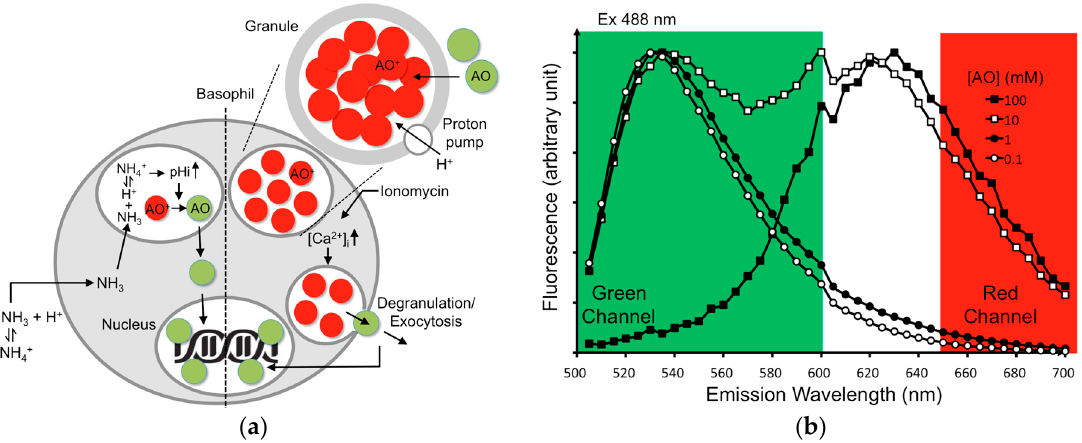
Figure 1. AO are trapped in the granules of basophils and exhibit red shift at high concentrations. Weakly basic AO molecules are selectively accumulated within granules as a result of the intragranular acidic pH. Upon entering the basophilic granules, AO dyes become protonated and are trapped inside the organelles ( a , right). The resulting high concentrations of AO cause a red shift, thereby giving red fluorescence after excitation at 488 nm. When challenged with NH 4 Cl, NH 4 Cl decomposes into ammonia in solution that passes through membranes easily, accumulating in the basophilic granules and promoting granular alkalinization to release AO ( a , left). When challenged with ionomycin, the intracellular Ca 2+ ion level ([Ca 2+ ] i ) increases, which triggers degranulation and releases AO externally ( a , right). The released AO dyes then bind to the nuclear DNA and generate strong green fluorescence ( a ). To demonstrate the phenomenon of red shift, AO was dissolved at the concentration (mM) as indicated (0.1 (open circle), 1 (solid circle), 10 (open square), 100 (solid square)). Emission spectrum of AO at each concentration was scanned from 500 to 700 nm with excitation at 488 nm; emission peak from the solutions of various AO concentrations was normalized to the same level for comparison because the quantum efficiency of the AO red fluorescence is much weaker than that of the green one. High concentrations of AO ( ≥ 10 mM) show a red shift ( b ).